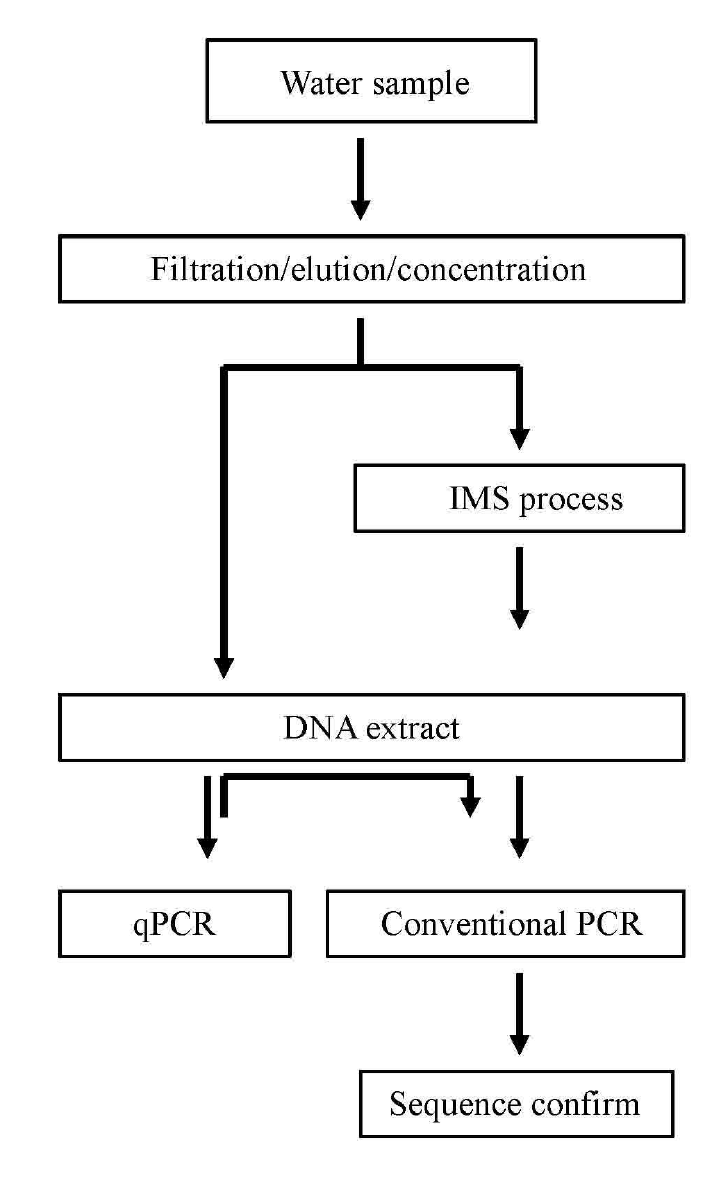
Figure 2. Schematic diagram of experimental setup and designated Salmonella